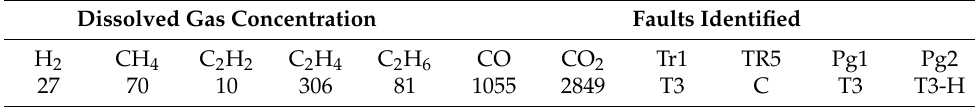
Table 12. Dissolved Gas Analysis (DGA) analysis and fault identification.